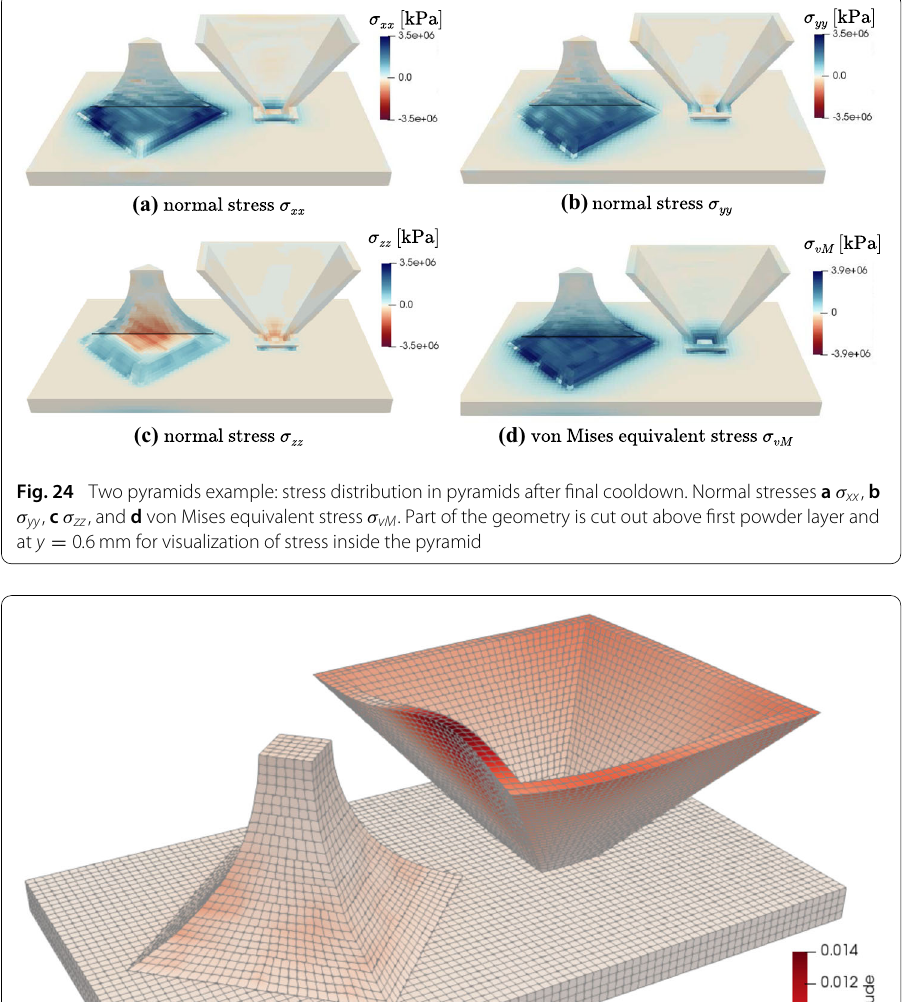
tent modeling of material behavior in a macroscale sense. To this end, a thermo-elastic material model with an additional inelastic reference strain contribution was derived and verified with academic test cases. Crucially, this inelastic reference strain contribution, formulated in rate form, was introduced to allow for a stress-free state when solidification of molten material starts. Compared to existing (instantaneous) stress-reset procedures, which might result in jumps in the stress-field, the formulation of the reference strain term in rate form guarantees a smooth stress field. Compared to more involved material models, e.g. [45,48], this simple approach can easily be integrated in standard material